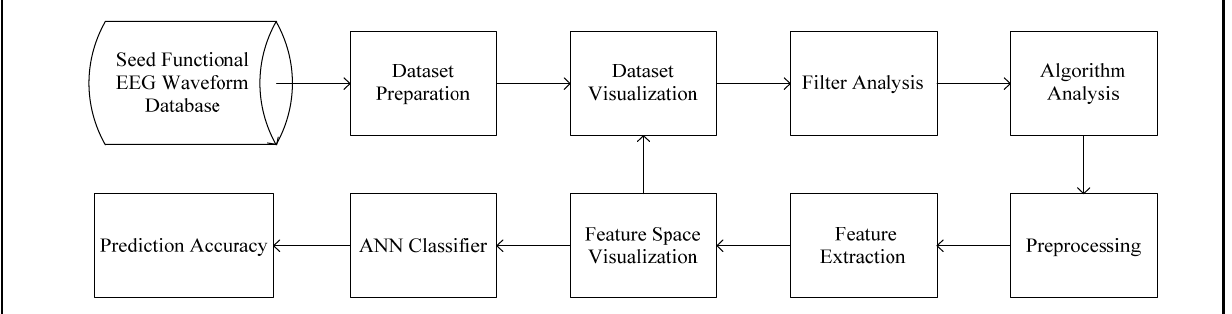
Figure 3. Flow diagram explaining research methodology in brief.